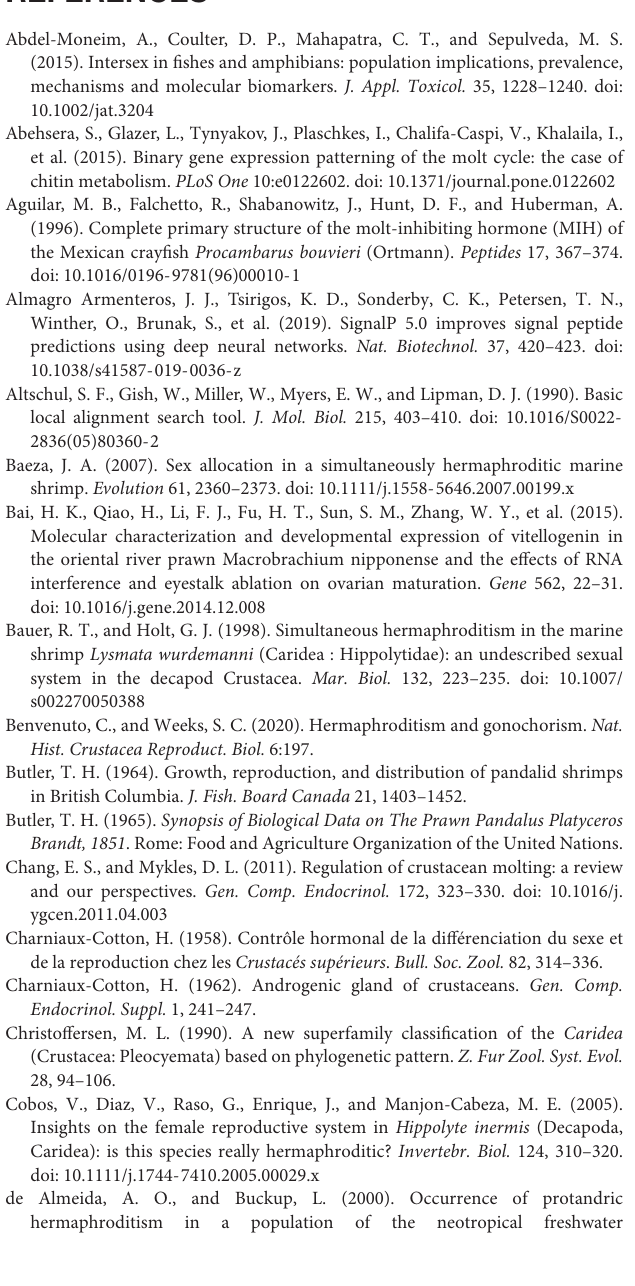
Supplementary Table 4 | Gene Ontology (GO) enrichment analysis of the differentially expressed genes between every possible contrast (I vs. M, I vs. YF, I vs. MF, YF vs. M, MF vs. M and YF vs. MF) in the H. inermis body transcriptome. The genes that were assigned to each term within the molecular function (MF; yellow) and biological process (BP; blue) aspects are indicated along with the fold enrichment and FDR adjusted p-values for each GO term. Supplementary Table 5 | Gene Ontology (GO) enrichment analysis of the differentially expressed genes between every possible contrast (I vs. M, I vs. YF, I vs. MF, YF vs. M, MF vs. M and YF vs. MF) in the H. inermis eye transcriptome. The genes that were assigned to each term within the molecular function (MF; yellow) and biological process (BP; blue) aspects are indicated along with the fold enrichment and FDR adjusted p-values for each GO term.